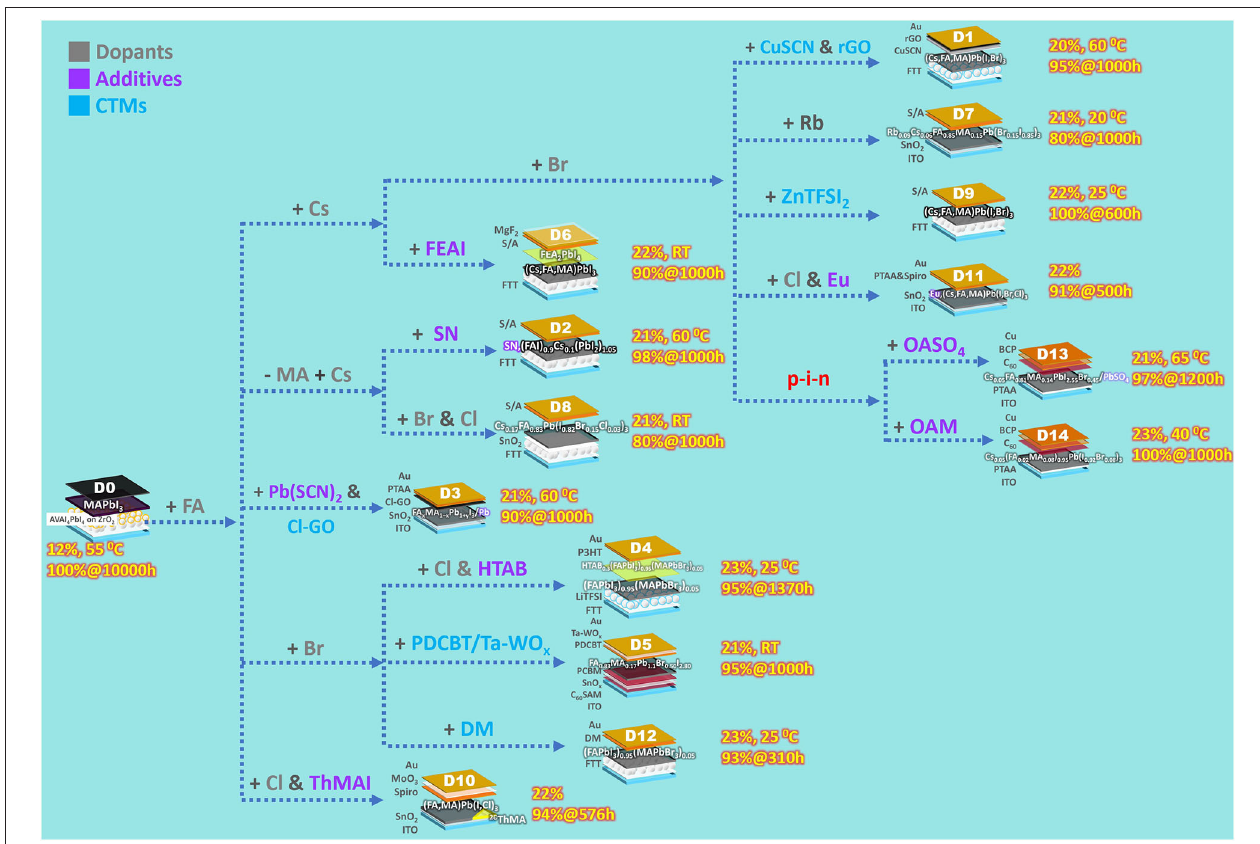
FIGURE 1 | PSC-stabilizing flowchart according to key components applied to a